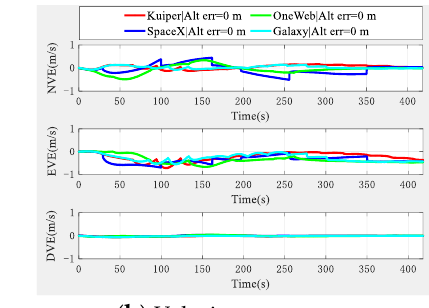
Figure 13. Comparison of altimeter-free multi-aircraft cooperative navigation and positioning algo- rithms based on the DWAPC-TSM system for different LEO constellations.